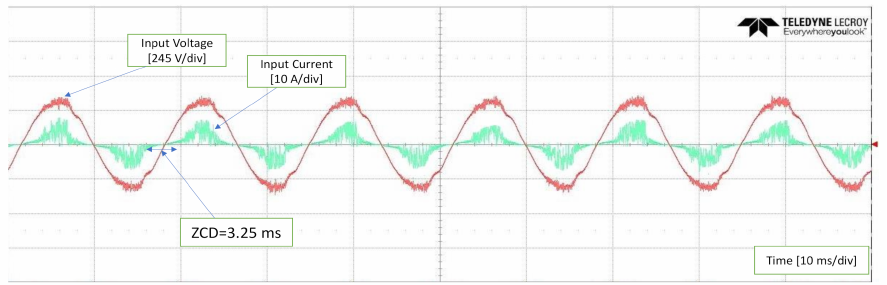
Figure 37. Experimental waveforms of the supply voltage-current with the conventional PI current controller at 25% loading condition.